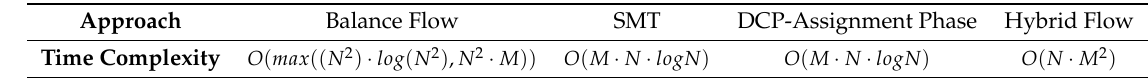
Table 1. Time complexity